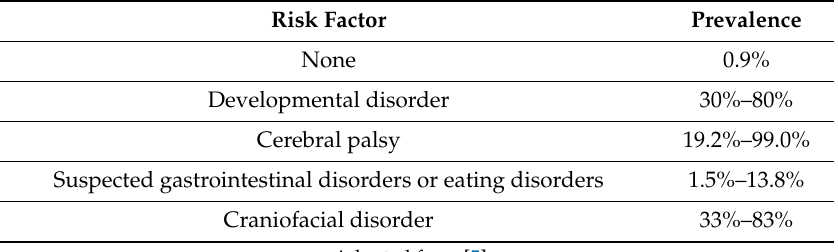
Table 1. Prevalence of dysphagia according to the underlying risk factors in pediatric